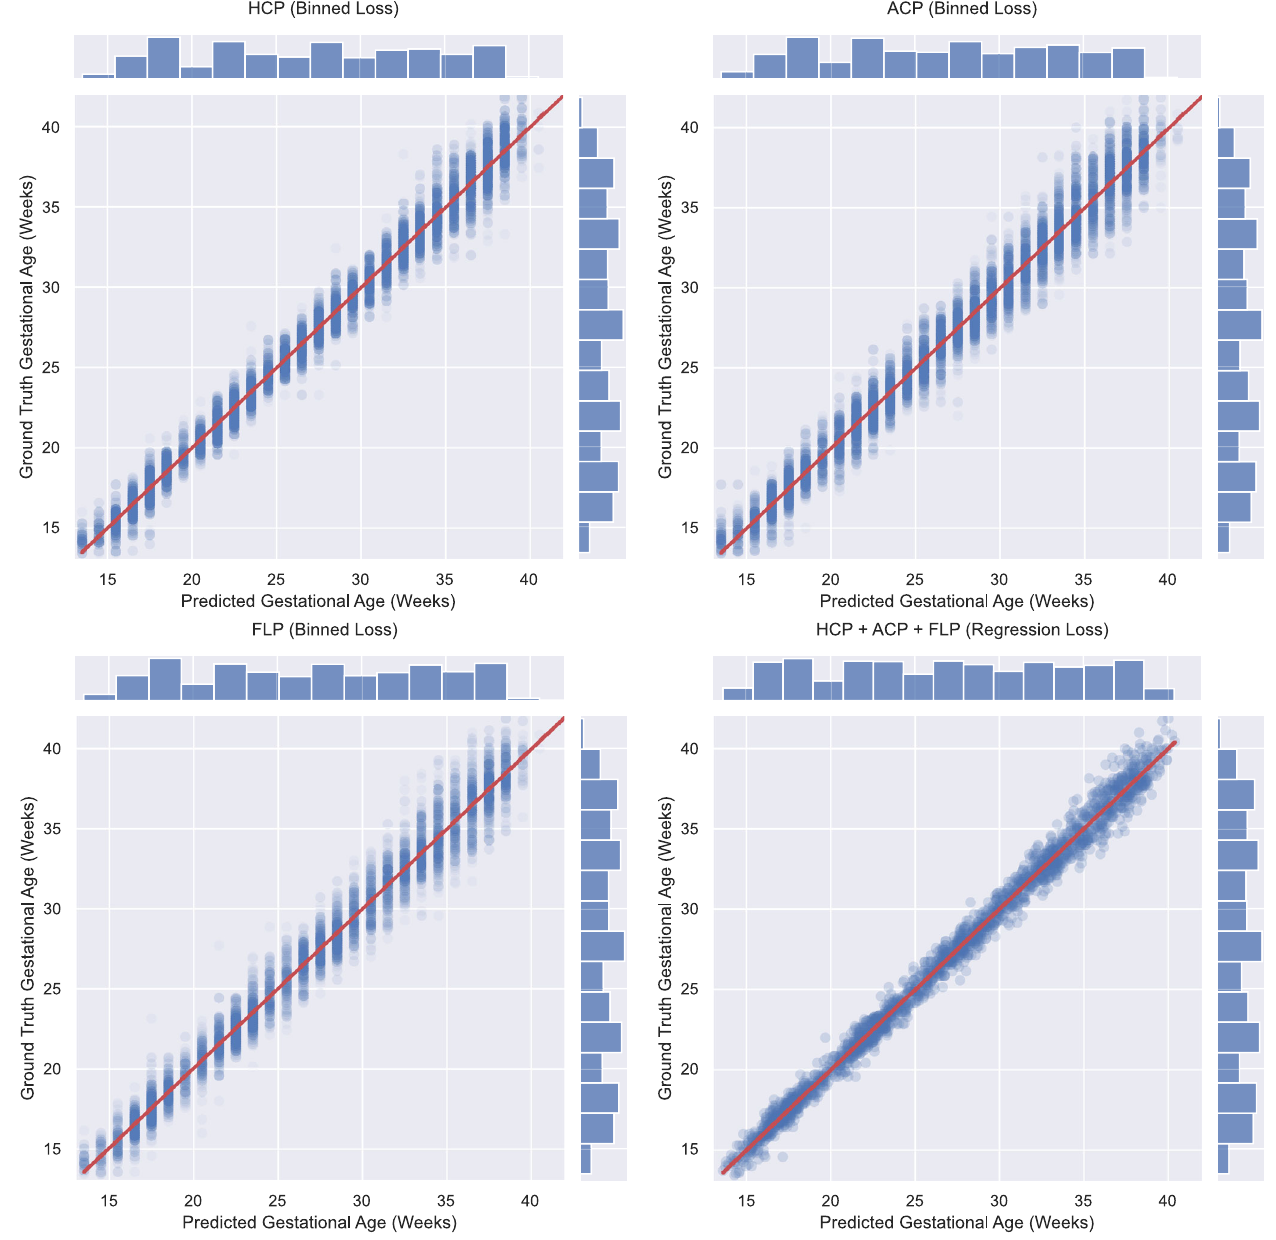
Fig. 1 Performance per plane and MutliPlane on the INTERGROWTH-21st internal validation set. Composite fi gure showing scatter plot of the performance of the proposed single standard plane and MultiPlane models on the hold-out INTERGROWTH-21st test set with histograms showing the spread of planes across gestational ages. HCP Head Circumference Plane, ACP Abdominal Circumference Plane, FLP Femur Length